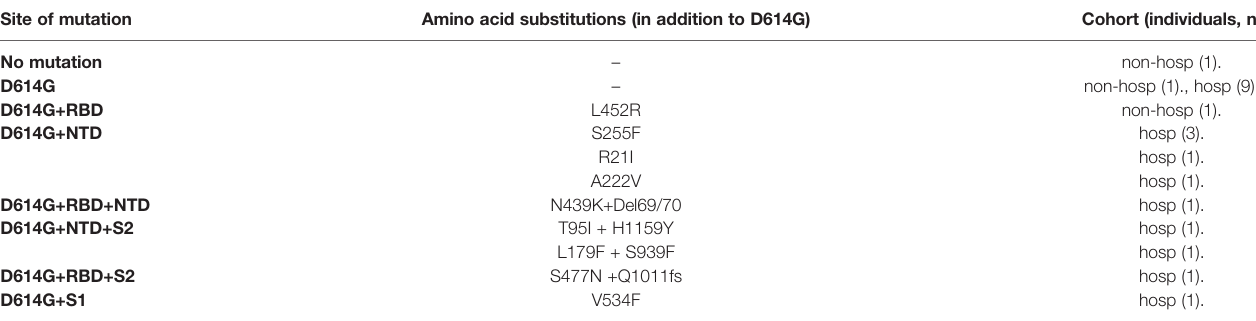
TABLE 3 | Speci fi c S mutations identi fi ed in infected